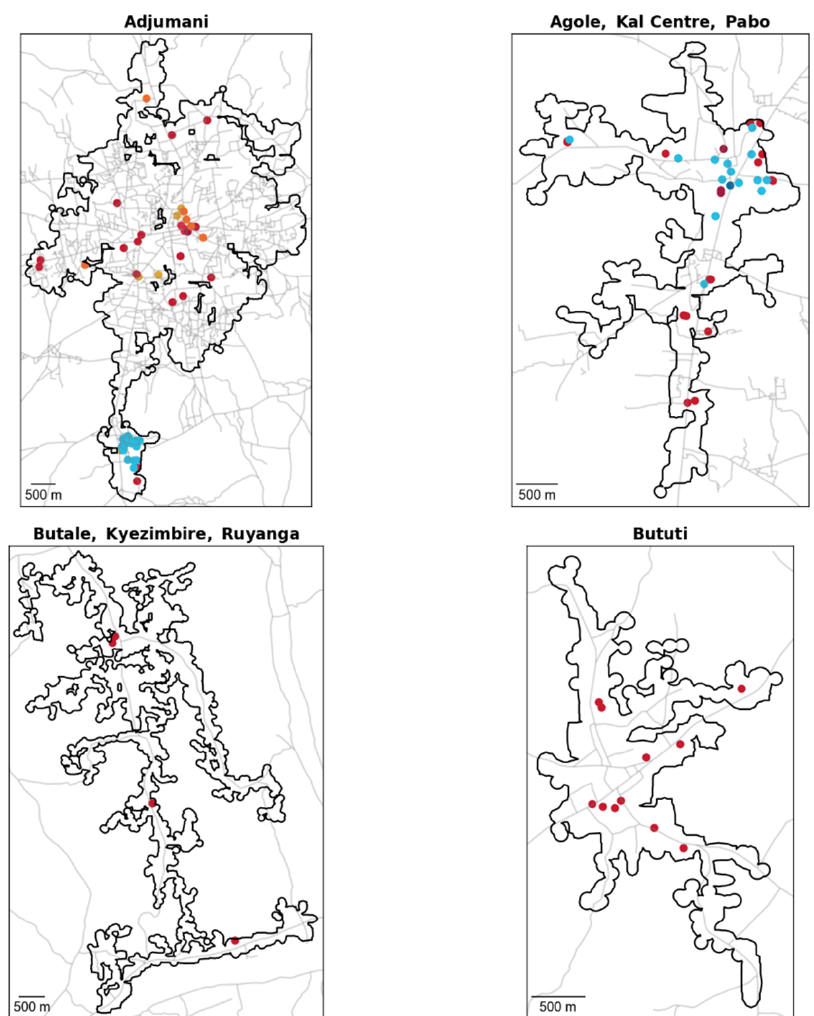
Table A1. SDG-OSM data model. OSM tags are shown as “key—value” pairs.